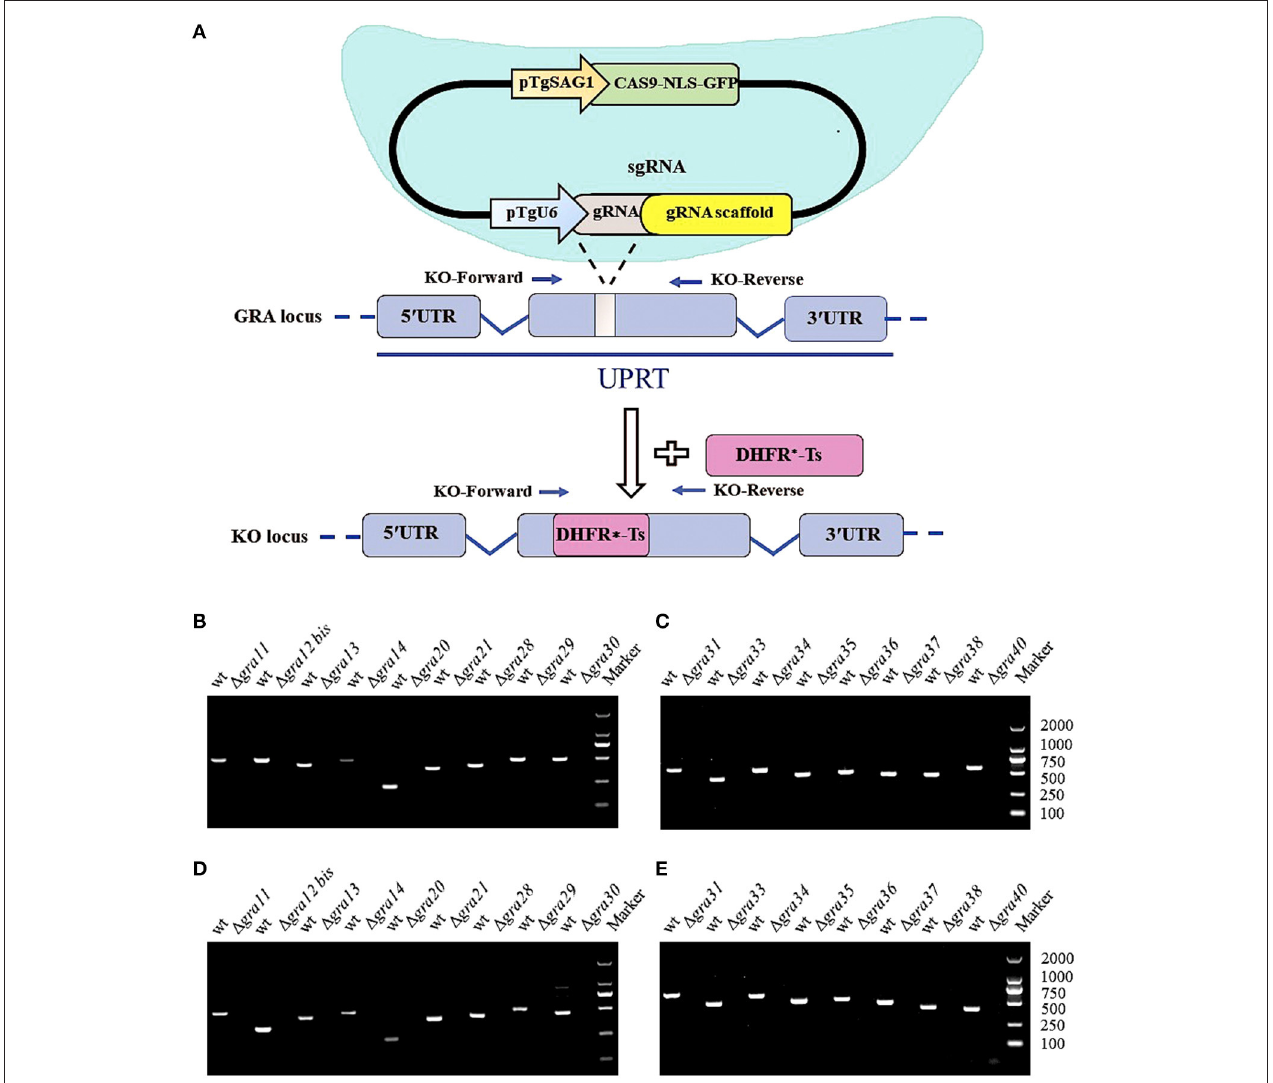
FIGURE 1 | Overview of the CRISPR/Cas9 system and mutation analysis of Toxoplasma gondii dense granule proteins (GRA) genes . (A) Schematic representation of CRISPR-Cas9 system used for disrupting the 17 GRAs genes by insertion of DHFR * -Ts cassette. (B,C) Diagnostic PCR shows GRA gene disruption in the mutants compared to the wild-type strain. The KO-forward and KO-reverse primers were used to amplify the small fragment with 30s extension time. (D,E) RT-PCR of mRNA from parental RH (WT) and GRA -deficient strains, showing that the 17 GRA’s coding sequences were successfully disrupted. Marker denotes the DNA ladder.